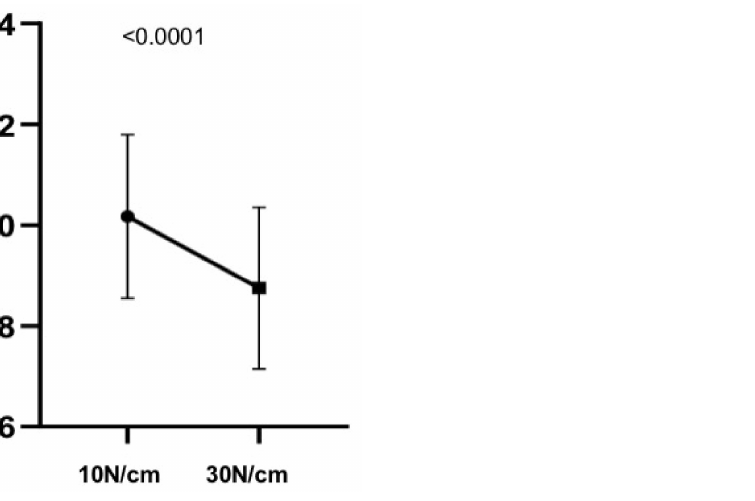
Figure 3. Chart showing a significant decrease in A–B distance between 10 N and 30 N in the pillars on the analogs (Group 1).